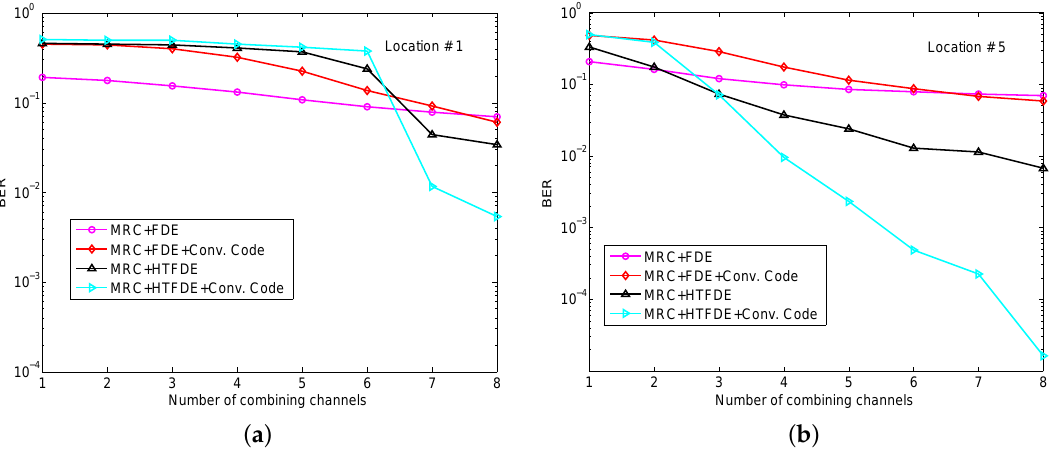
Figure 8. BER performance using conventional multichannel FDE and HTFDE at one location: ( a ) Location #1 and ( b ) Location